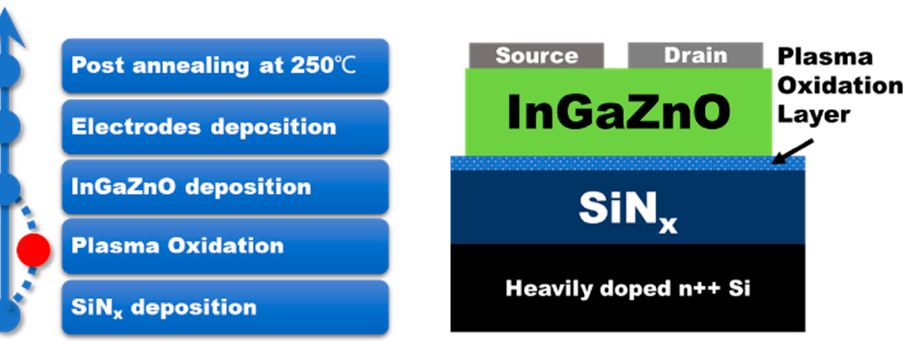
Figure 1. Process flow diagram and structure of InGaZnO TFT in this work.